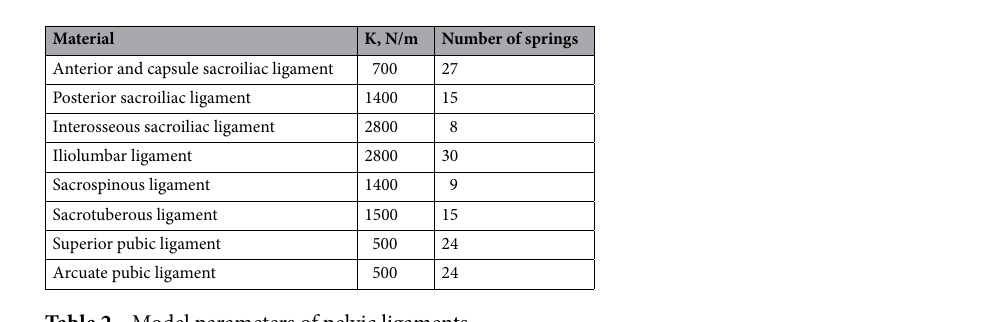
Table 2. Model parameters of pelvic ligaments.